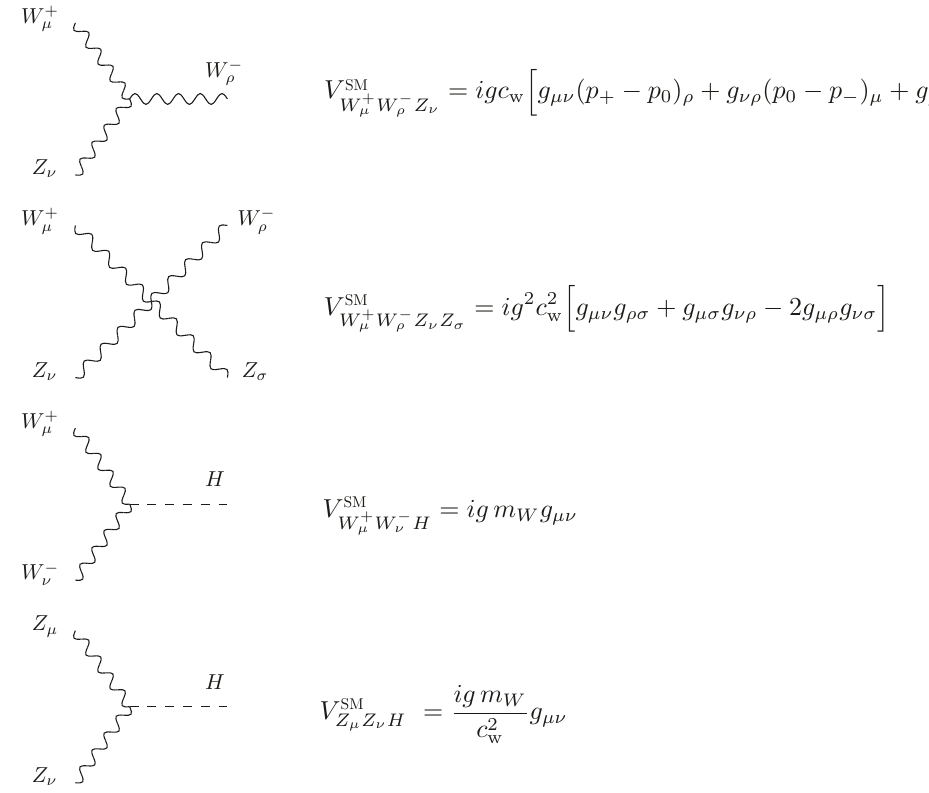
Figure 18 . Relevant Feynman rules for the WZ as